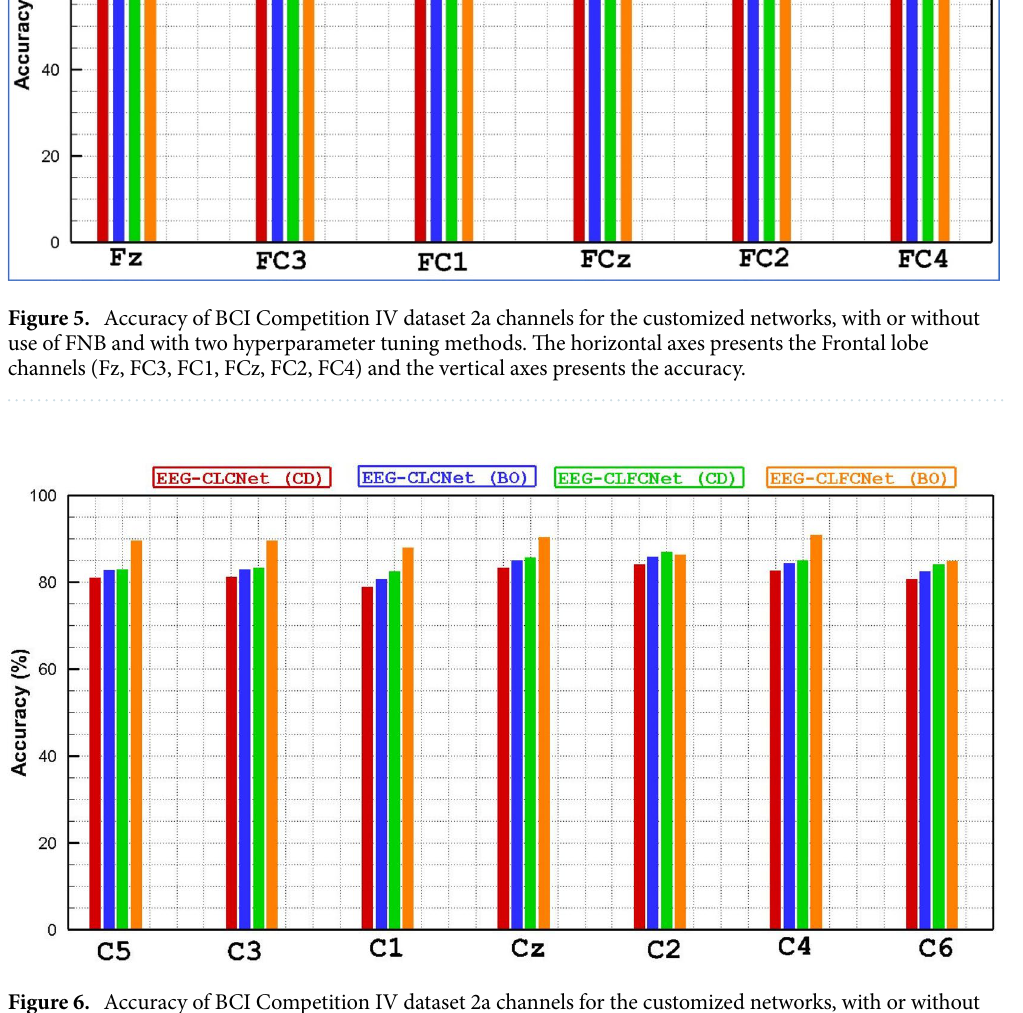
Figure 6. Accuracy of BCI Competition IV dataset 2a channels for the customized networks, with or without use of FNB and with two hyperparameter tuning methods. The horizontal axes presents the Frontal lobe channels (C5, C3, C1, Cz, C2, C4, C6) and the vertical axes presents the